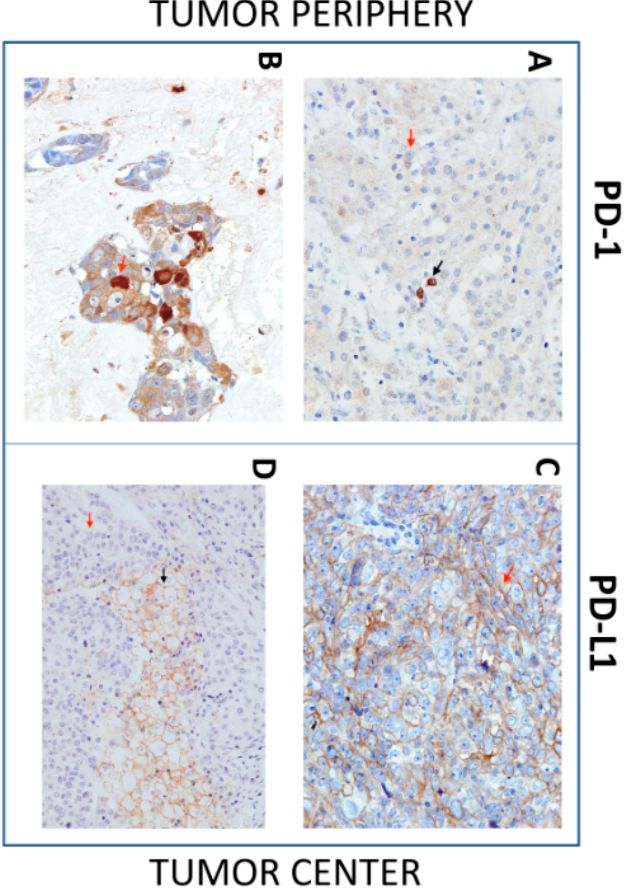
Figure 2. Immunohistochemistry (IHC) of Programmed cell death protein-1(PD-1) and Programmed cell death protein-1 ligand (PD-L1) expression in SGC tissues. Representative images show PD-1 or PD-L1 expression in tumor cells (red arrow) and tumor-infiltrating immune cells (TIICs), (black arrow) in the tumor periphery (left images) and tumor center (right images). ( A ) IHC shows positive PD-1 expression in TIICs and negative PD-1 expression in tumor cells (40 × ). ( B ) IHC shows positive PD-1 expression in tumor cells (40 × ). ( C ) IHC shows positive PD-L1 expression in tumor cells (40 × ). ( D ) IHC shows PD-L1-positive TIICs and PD-L1-negative tumor cells (40 ×